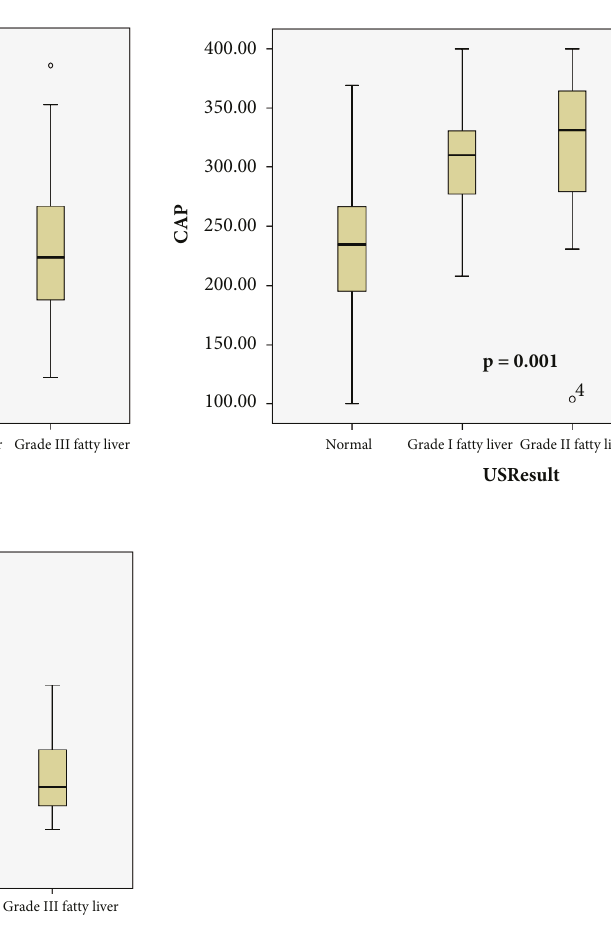
increase by 31.9dB/m with every increment in liver steatosis